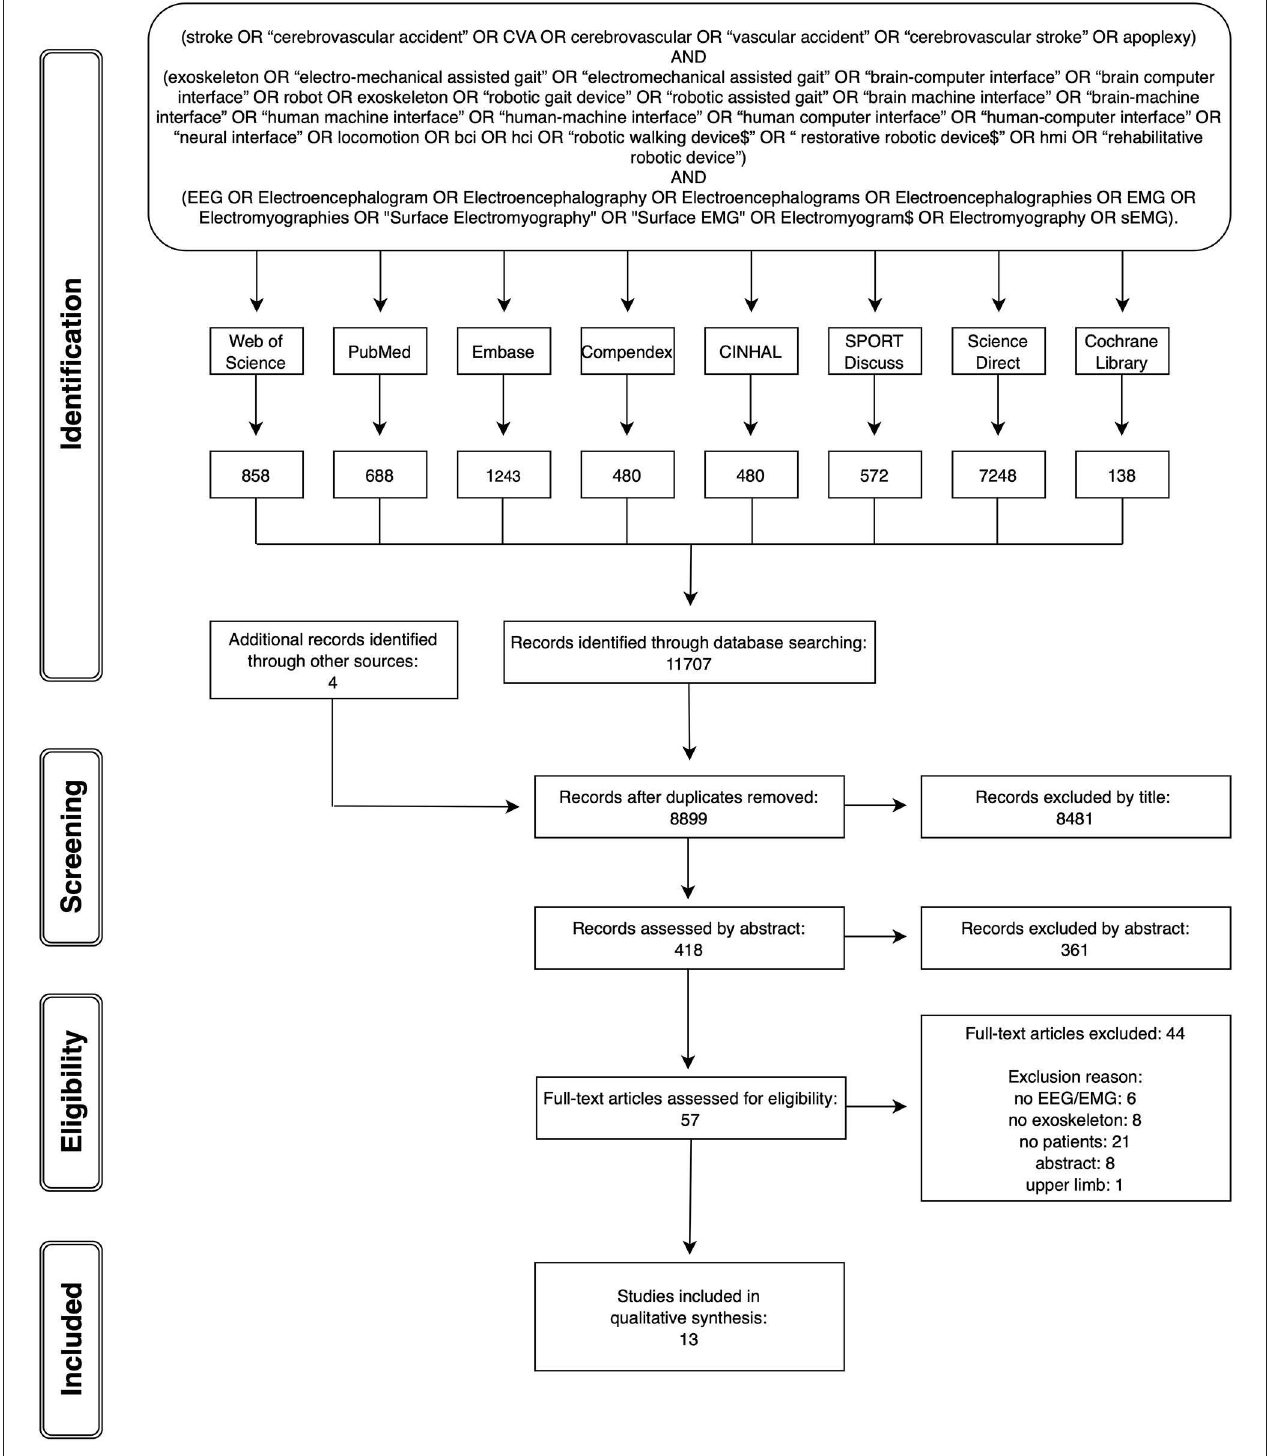
FIGURE 1 | PRISMA flow chart with sample search